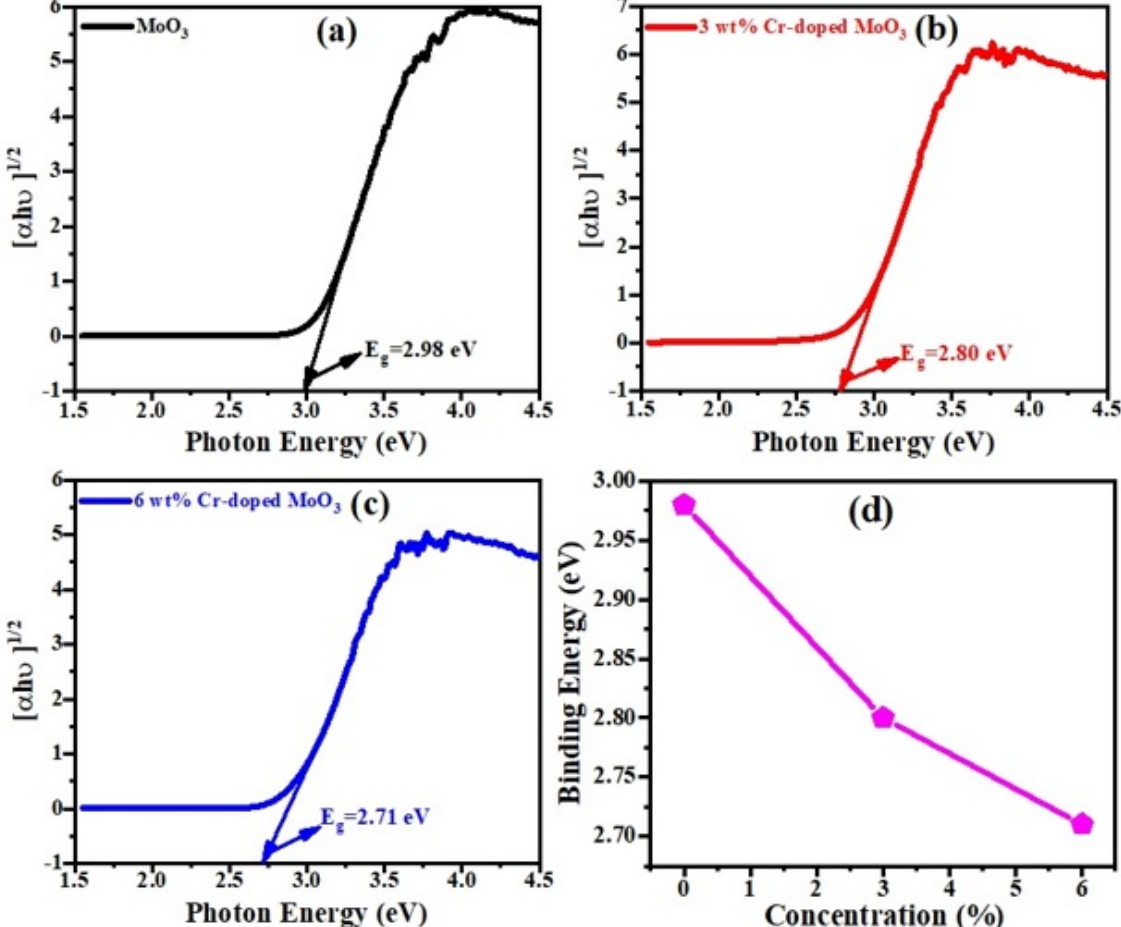
Figure 6. K-M function graph of ( a ) un-doped, ( b ) 3 wt%, ( c ) 6 wt% Cr-doped MoO 3 . ( d ) Optical band gap energy.